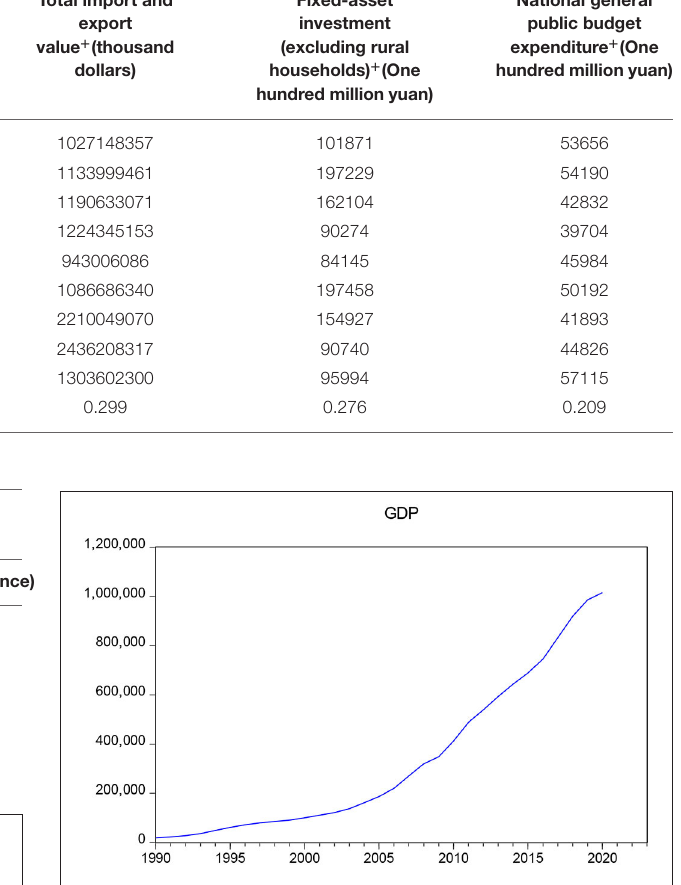
FIGURE 3 | Time series chart of GDP data from 1990 to